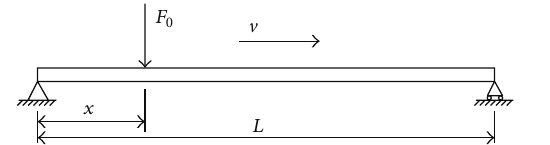
Figure 1: Simply supported beam subjected to a moving concen- trated force.